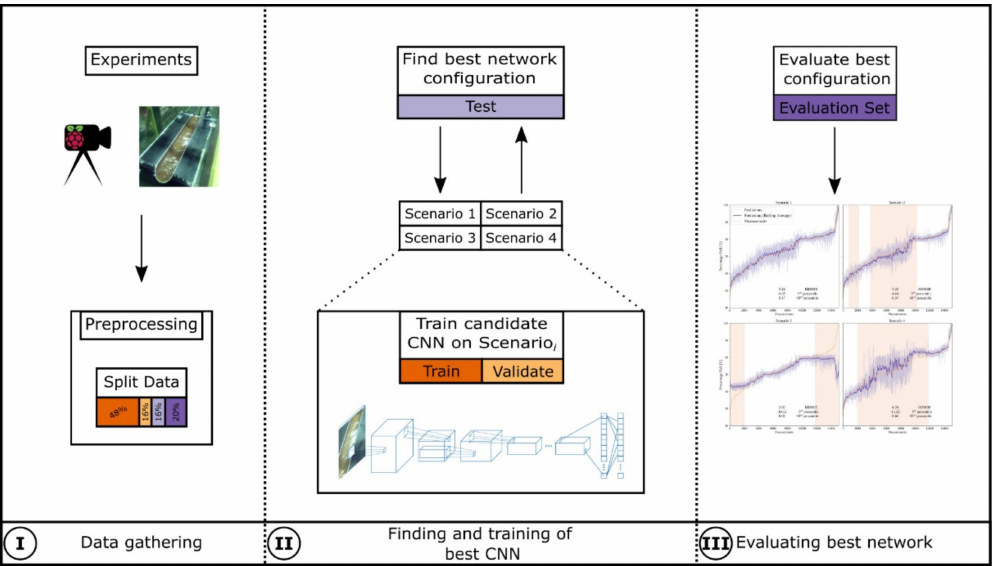
Figure 1. Flowchart of the applied